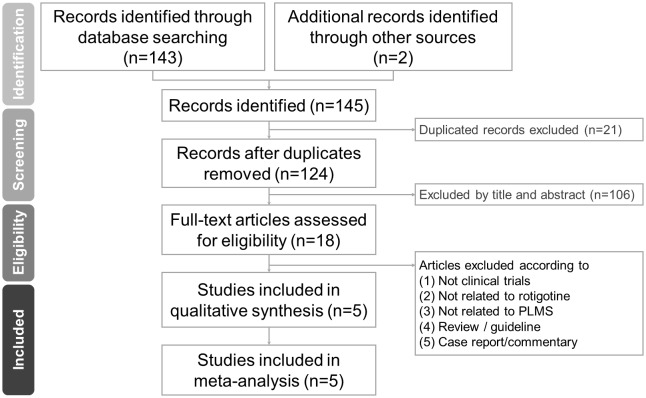
Flowchart of the selection strategy for meta-analysis according to PRISMA guidelines.